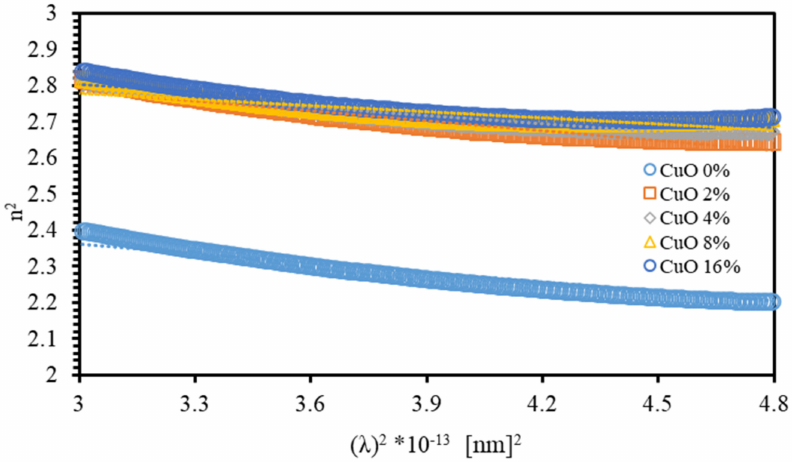
Figure 11. The variation of the real part of the dielectric constant ( n 2 = ε (cid:48) ) with the square of the photon wavelength ( λ 2 ) for PMMA–PVA/CuO